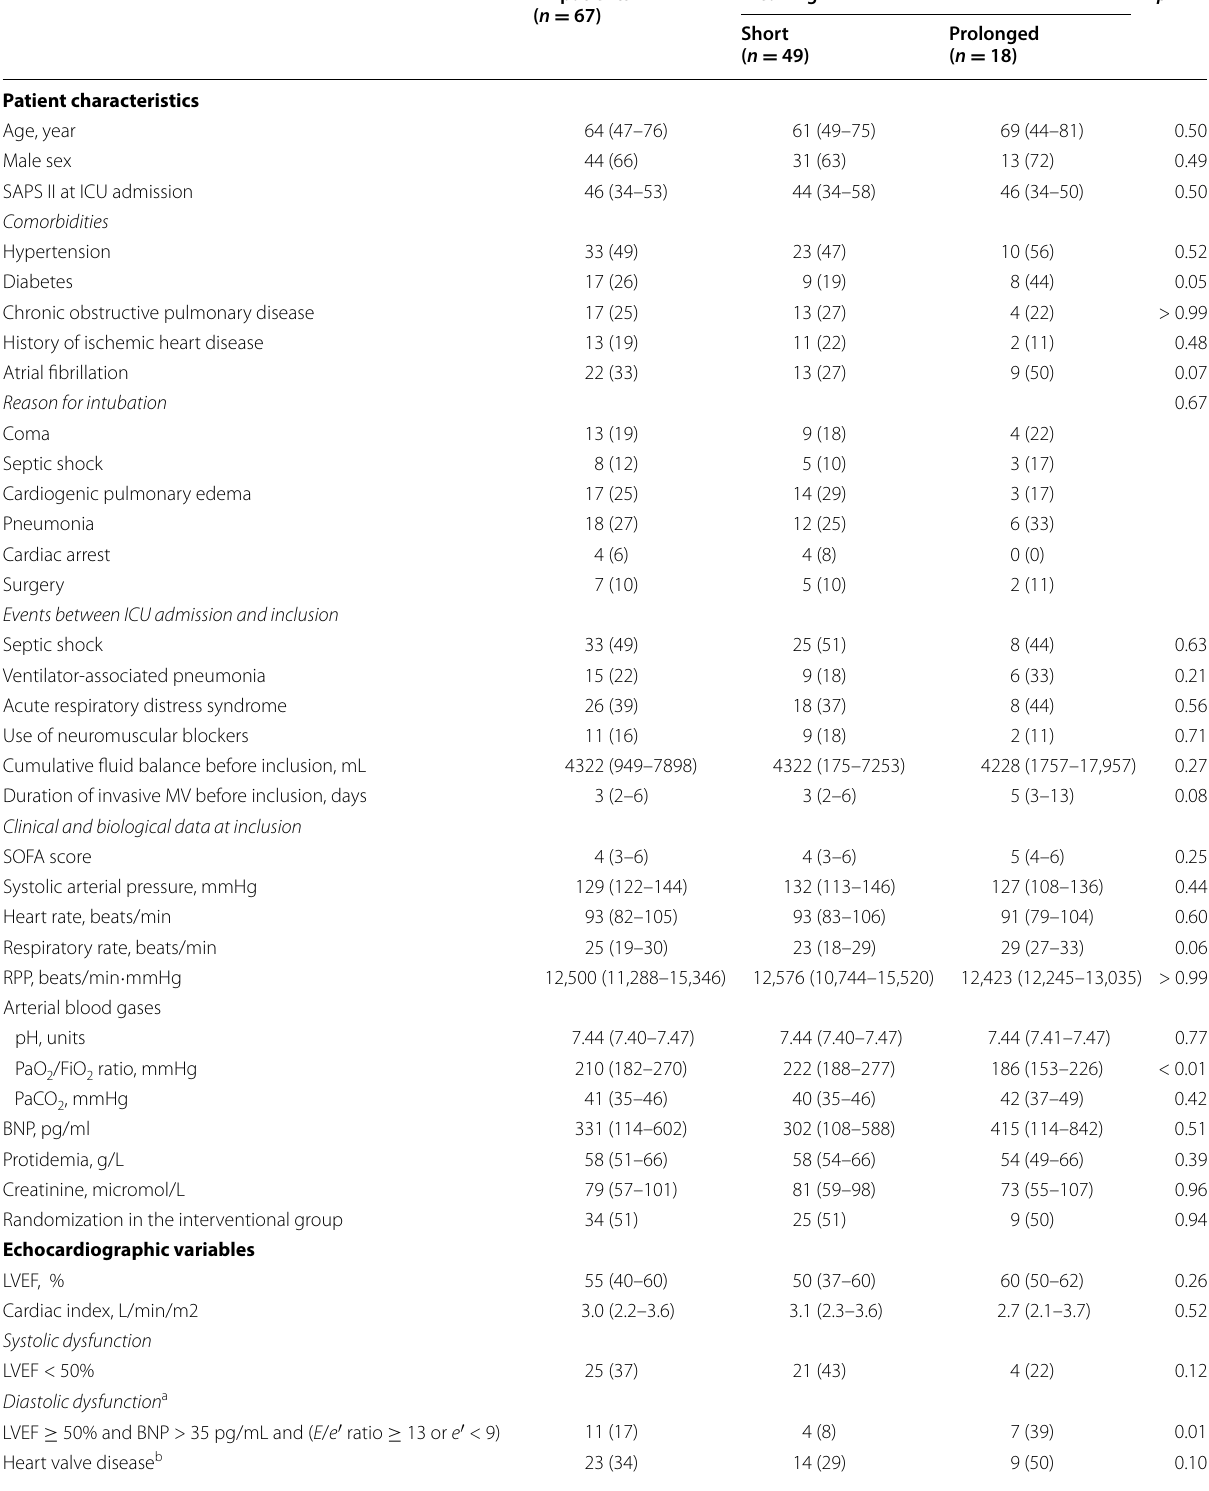
Table 1 Patient characteristics and echocardiographic variables just before the weaning process, according to